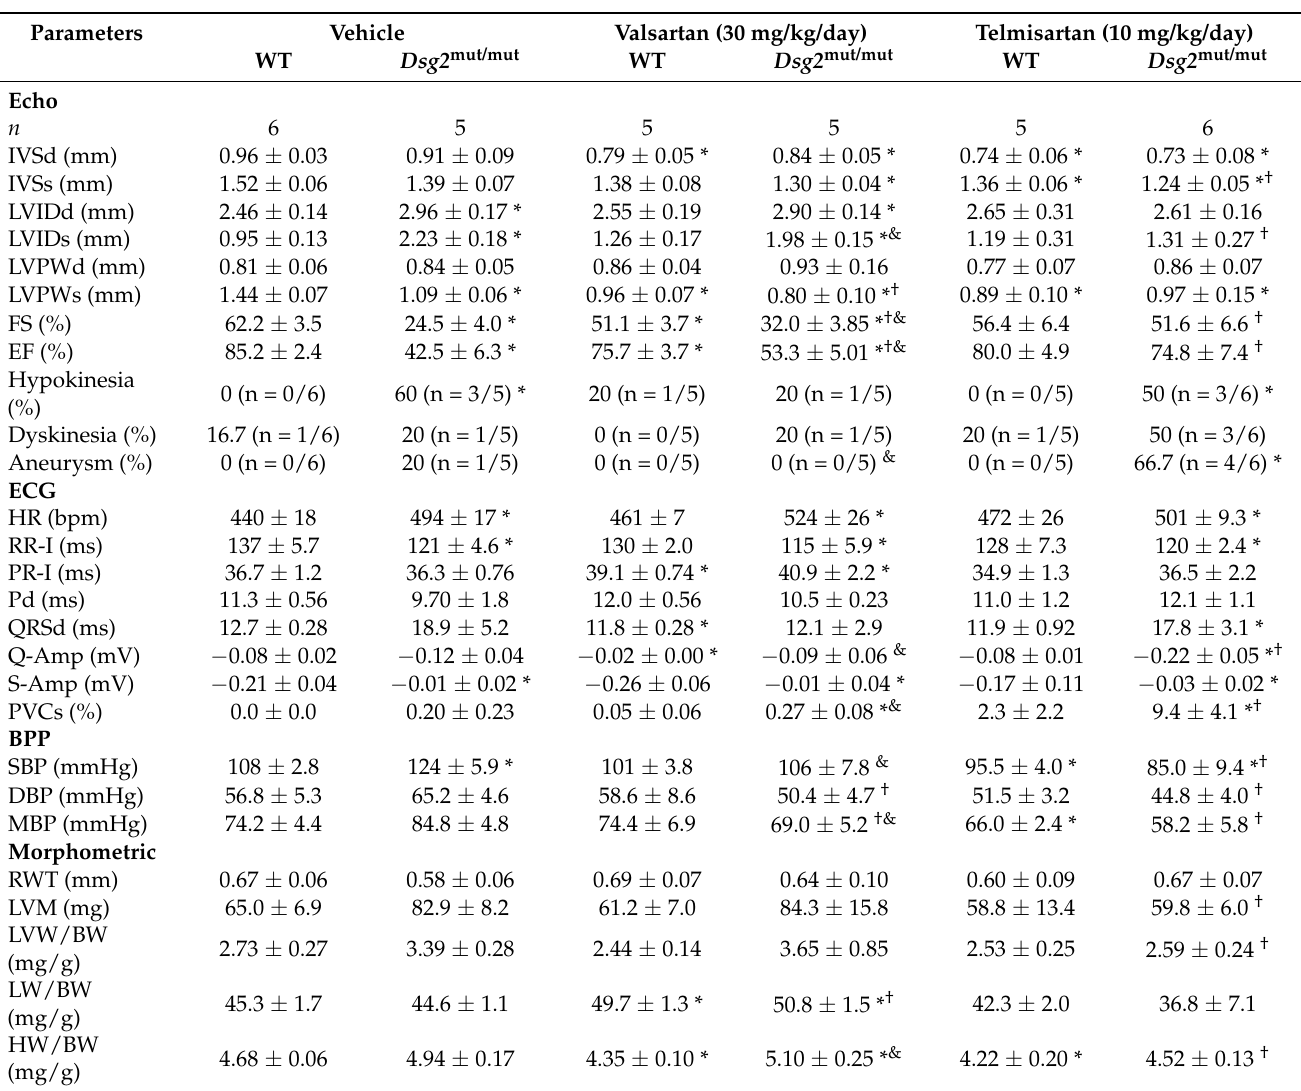
Table 1. Echocardiographic, electrocardiographic, blood pressure plethysmography, and mor- phometric indices from Vehicle- and Drug-treated WT and Dsg2 mut/mut mice at 16 weeks of age. IVSd, interventricular septal end-diastolic volume; IVSs, interventricular septal end-systolic volume; LVIDd, left ventricular internal diameter end-diastolic volume; LVIDs, left ventricular internal diame- ter end-systolic volume; LVPWd, left ventricular posterior wall end diastole; LVPWs, left ventricular posterior wall end systole; FS, fractional shortening; EF, ejection fraction; HR, heart rate; RR-I, R-R interval; PR-I, P-R interval; Pd, P-wave duration; QRSd, QRS duration; Q-Amp, Q-wave amplitude; S-Amp, S-wave amplitude; PVC, premature ventricular contraction; BPP, blood pressure plethys- mography; SBP, systolic blood pressure; DBP, diastolic blood pressure; MBP, mean blood pressure; RWT, relative wall thickness; LVM, left ventricular mass; LVW/BW, left ventricular weight to body weight; LW/BW, liver weight to body weight; HW/BW, heart weight to body weight. Data pre- sented as mean ± SEM, * p < 0.05 for any cohort vs. Vehicle-treated WT mice; † p < 0.05 any drug-treated Dsg2 mut/mut cohort vs. Vehicle-treated Dsg2 mut/mut mice; & p < 0.05 for Valsartan- treated Dsg2 mut/mut mice vs. Telmisartan-treated Dsg2 mut/mut mice using One-way ANOVA with Tukey’s post-hoc